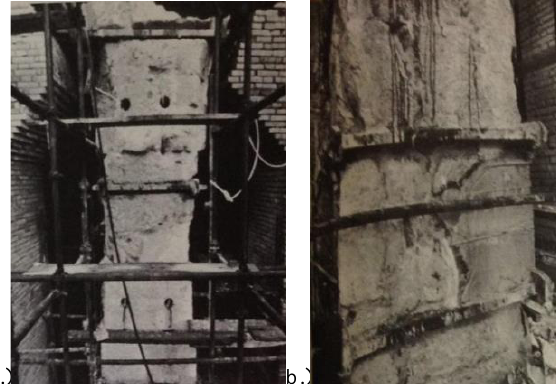
Figure 9. Drawings of the retrofit intervention project about the Figure 11. a.) Image of the harmonic steel cables in the connection of the columns of the first floor with the travertine columns during the phase of work. b.) Reconstruction orthogonal masonry walls. of the pillar section with epoxy resin and travertine pieces.